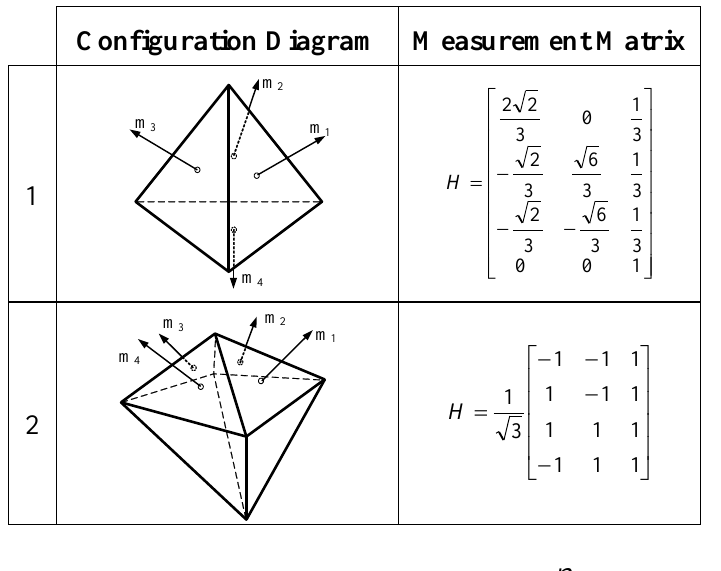
In HH T  for . 3 Measurement